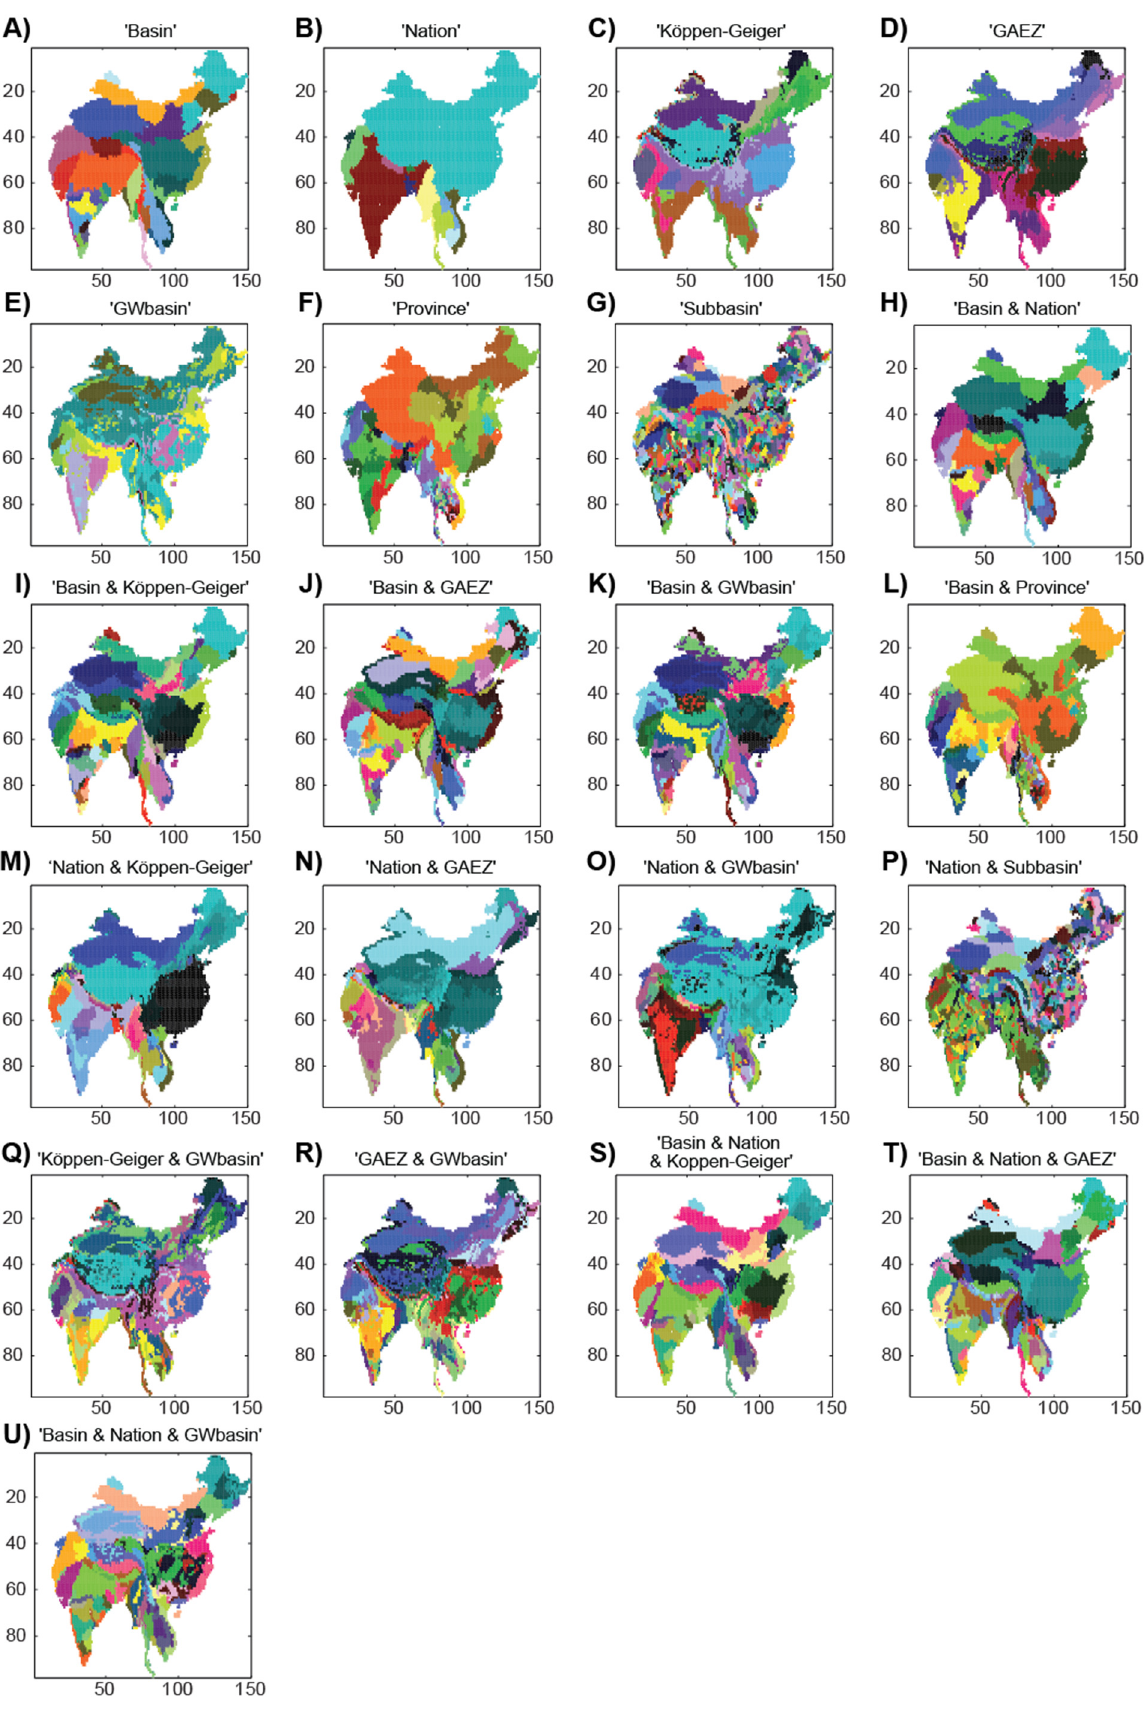
Figure 2. The 21 different zonings mapped. Data sources are presented in Table